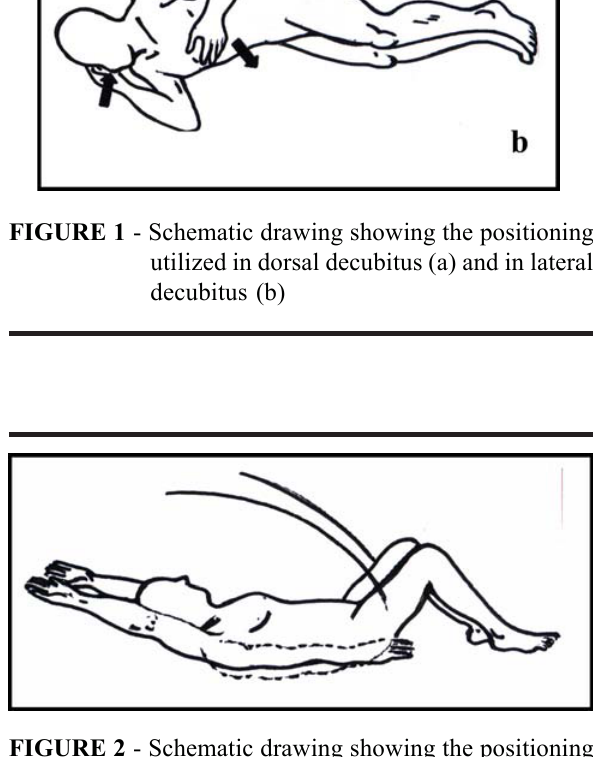
FIGURE 2 - Schematic drawing showing the positioning utilized in dorsal decubitus and the elevation of superior members during